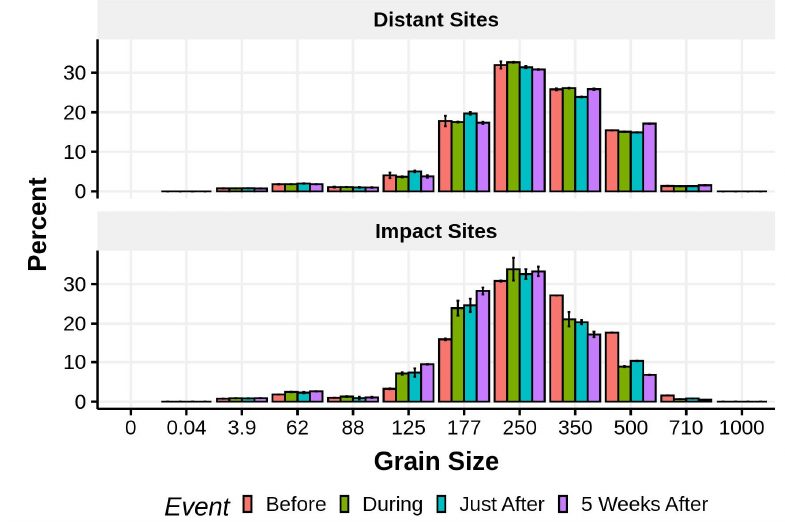
Figure 17. Mean (±1 SE) percent grain size composition of sediment samples taken from the distant and impact sites before, during, just after, and 5 weeks after nourishment.